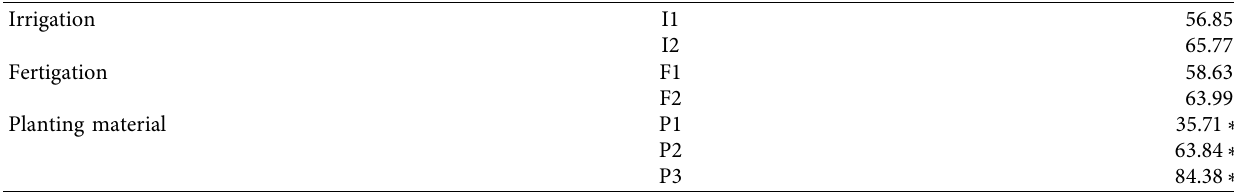
Table 3: Mean comparison of bacterial wilt incidence (%) in tomato (GS-600) grafts and nongrafted seedlings (2017-18). Irrigation I1 56.85 I2 65.77 Fertigation F1 63.99 Planting material P1